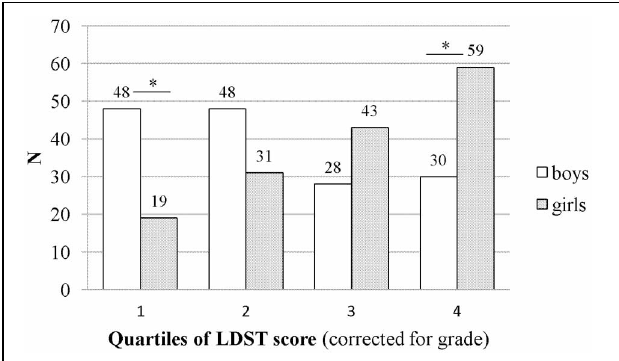
FIGURE 1 | Sex differences in LDST performance divided over quartiles. Note: Quartile 1 = 25% lowest LDST scores; quartile 4 = 25% highest LDST scores. ∗ p < 0 . 001.